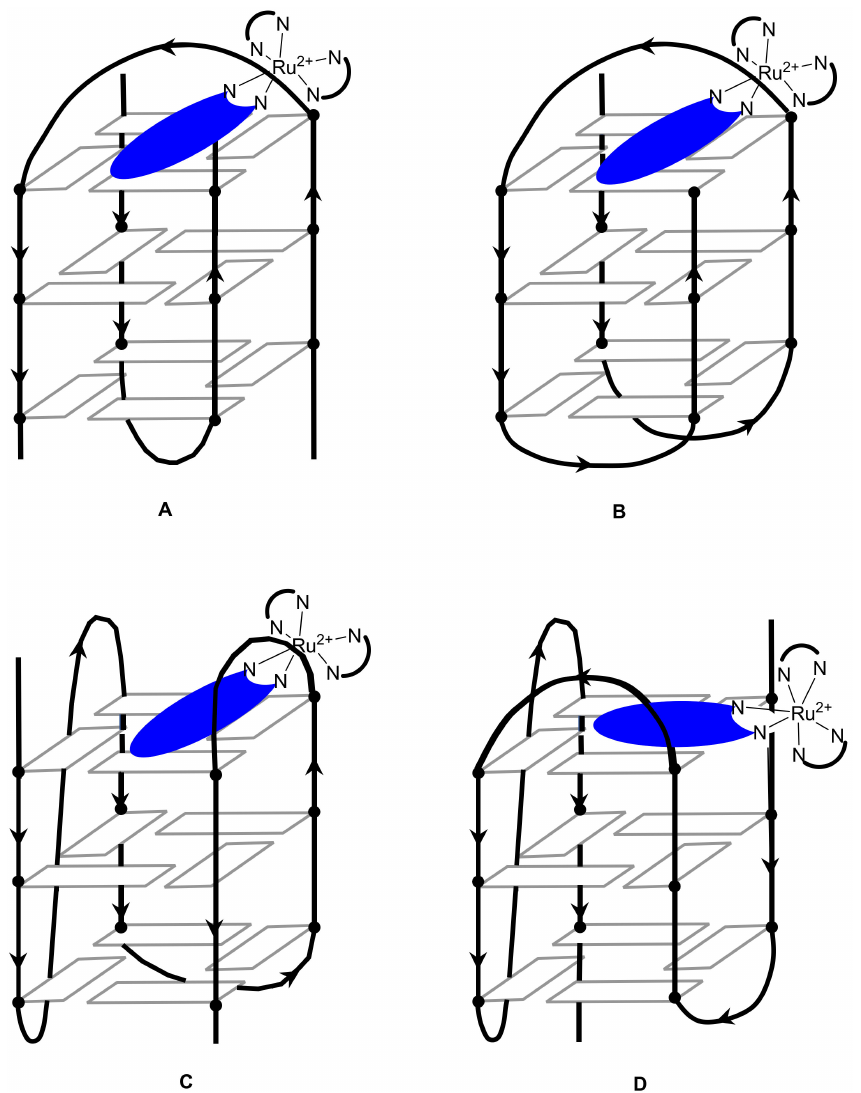
Figure 14. Binding interactions of [Ru(phen) 2 dppz] 2+ with ( A )—G4T4G4 (K + ), ( B )—G-HT (Na + ), ( C )—G-HT (K + ) Hybrid 1, ( D )—G-HT (K + ) Hybrid 2; using time-resolved infrared spectroscopy as proposed by Devereux et al. [197] (G4T4G4 = Oxytricho nova telomere sequence [d(G 4 T 4 G 4 )] 2 , G-HT = human telomere sequence d[AG 3 (T 2 AG 3 ) 3